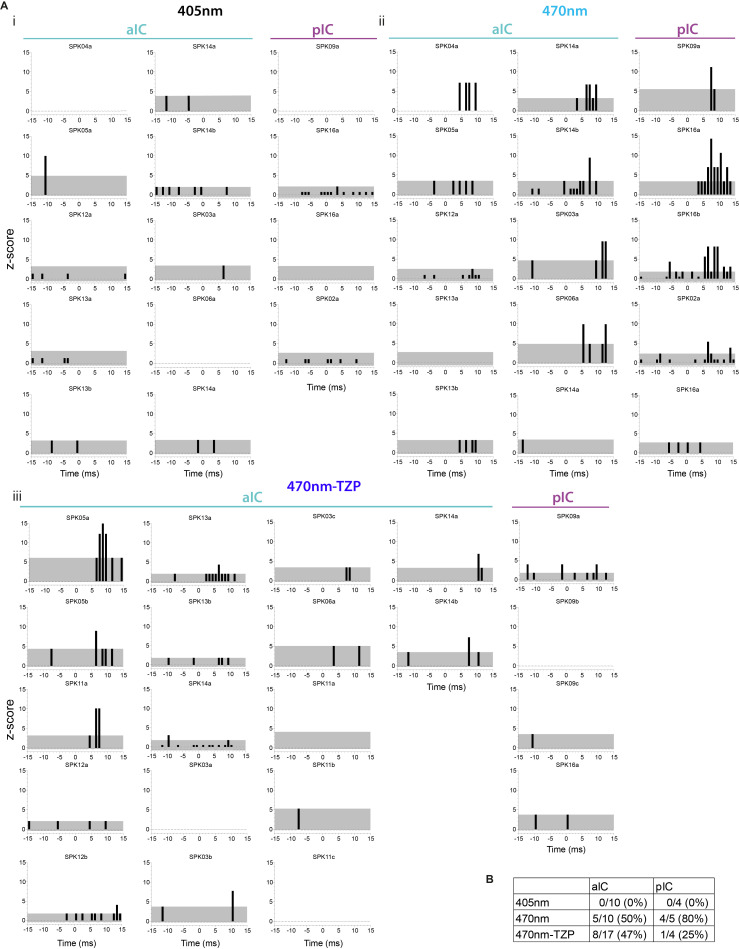
Optogenetic CE–NBM stimulation increases spiking of single neurons in aIC and pIC.(A) Peri-laser stimulus time histograms of single unit activity in aIC and pIC upon the (i) control stimulus (405 nm, 60 5 ms pulses), (ii) CEPKCδ-NBM stimulation (470 nm, 60 5 ms pulses) and (iii) CEPKCδ-NBM stimulation after systemic administration of TZP (470 nm-TZP, 40 5 ms pulses). Gray area indicates 95% confidence interval (CI). (B) Summary table of responding neurons above 95% CI after laser stimulation.